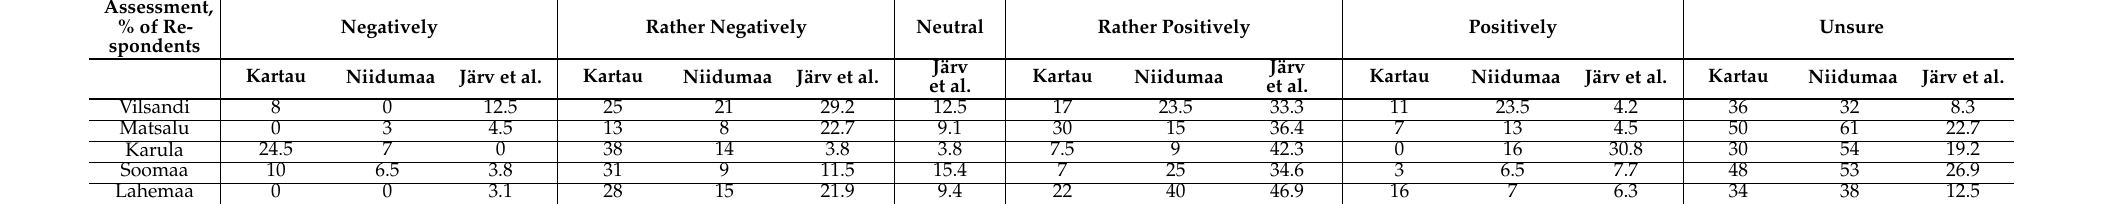
Table 4. National park effect on real estate prices, by park (Kartau, 1998; Niidumaa, 2009; Järv et al.,